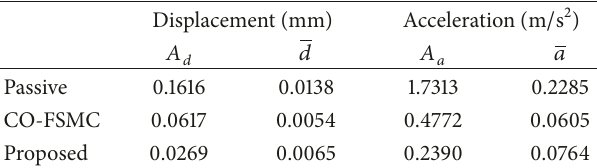
Figure 13: The sine-type track profile: vertical chassis acceleration corresponding to each method. Table3:Thebump-typedtrackprofile:verticalchassisdisplacement and acceleration.